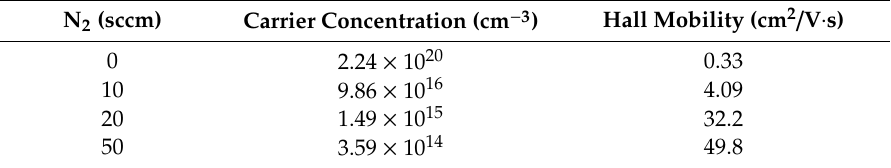
Table 2. Hall measurement results of CuON films grown at various N 2 flow